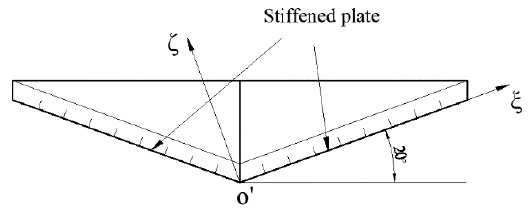
Figure 2. The cross section of the 3D wedge.